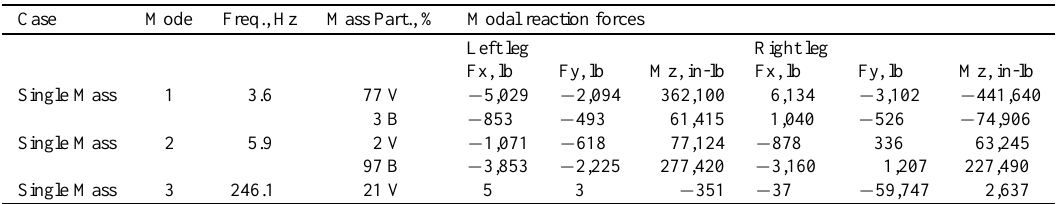
Table 6 Shock analysis results for single mass rod cases; Asymmetric mass